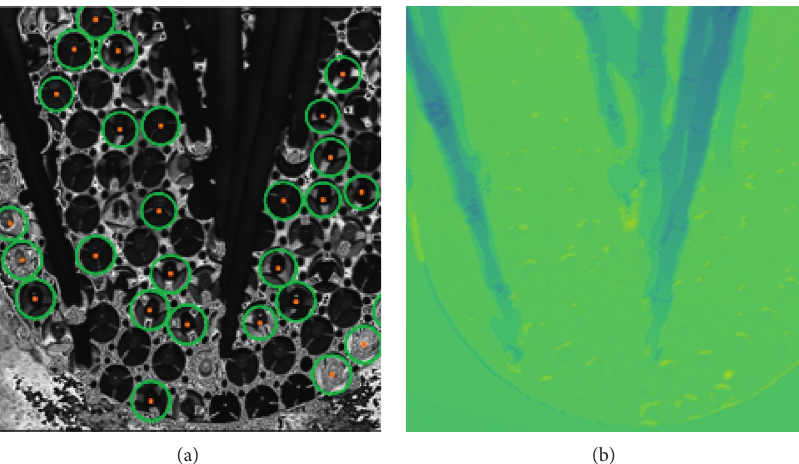
Figure 8: (a) Intensity image with detected shapes overlapped; (b) Depth map for estimating the dimensions of the detected